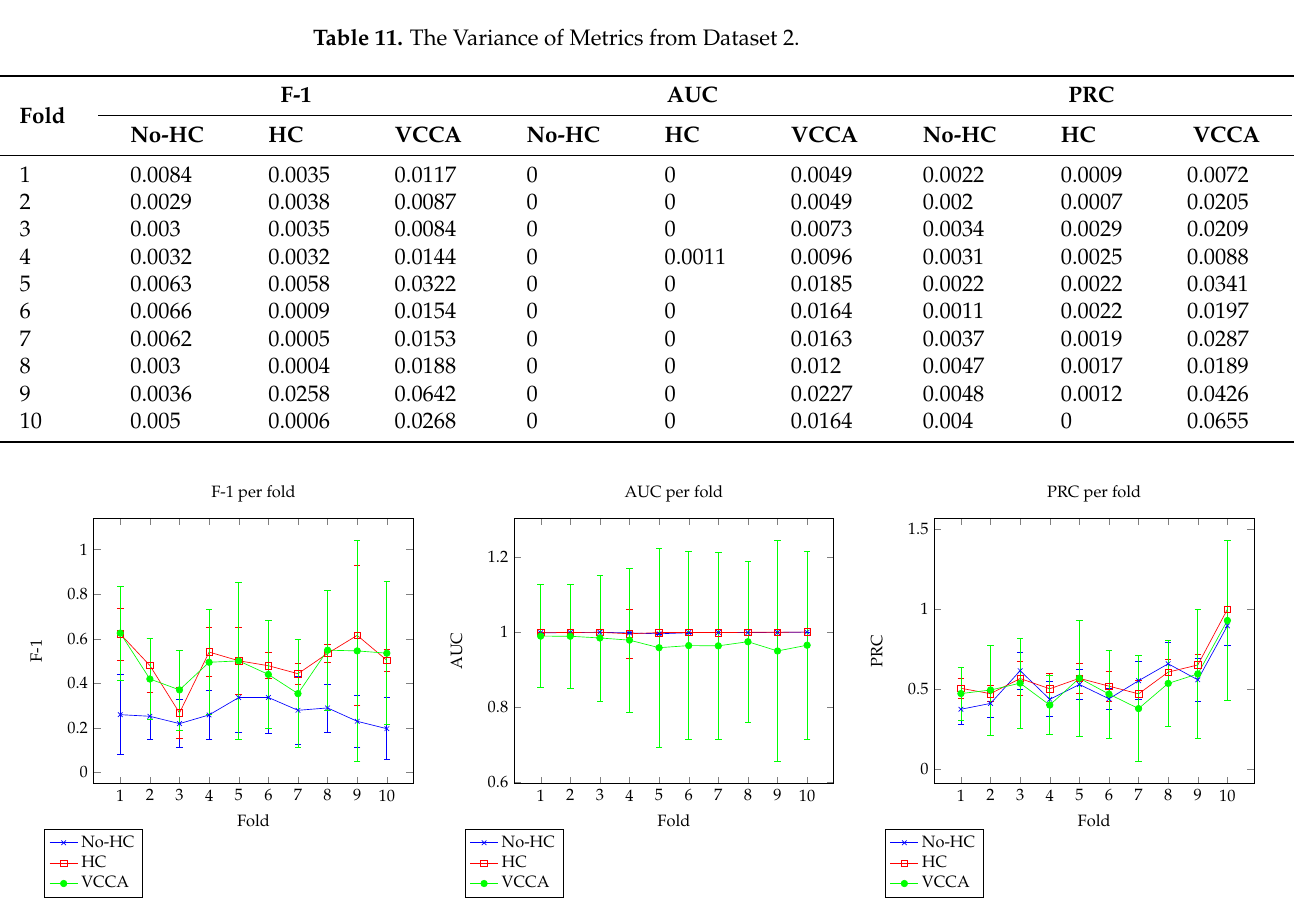
Figure 8. Mean values for the metrics applied on Dataset